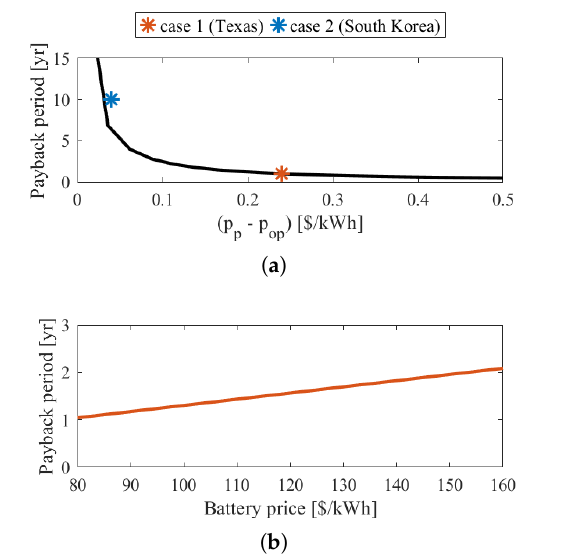
Figure 7. Benefits of ESS. ( a ) Payback period and electricity price gap: battery price = 100 $/kWh, refrigerator. ( b ) Payback period and battery cost: ( p o − p op ) = 23.5 ¢/kWh, refrigerator.